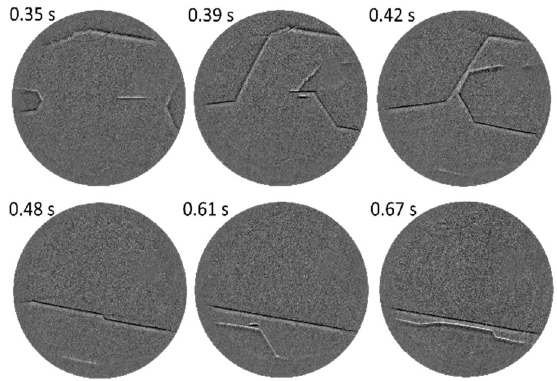
Figure 2. The instantaneous images of domain structure during the polarization reversal without artificial dielectric layer. Optical microscopy, transmitted light. Applied field 5.2 kV/mm.